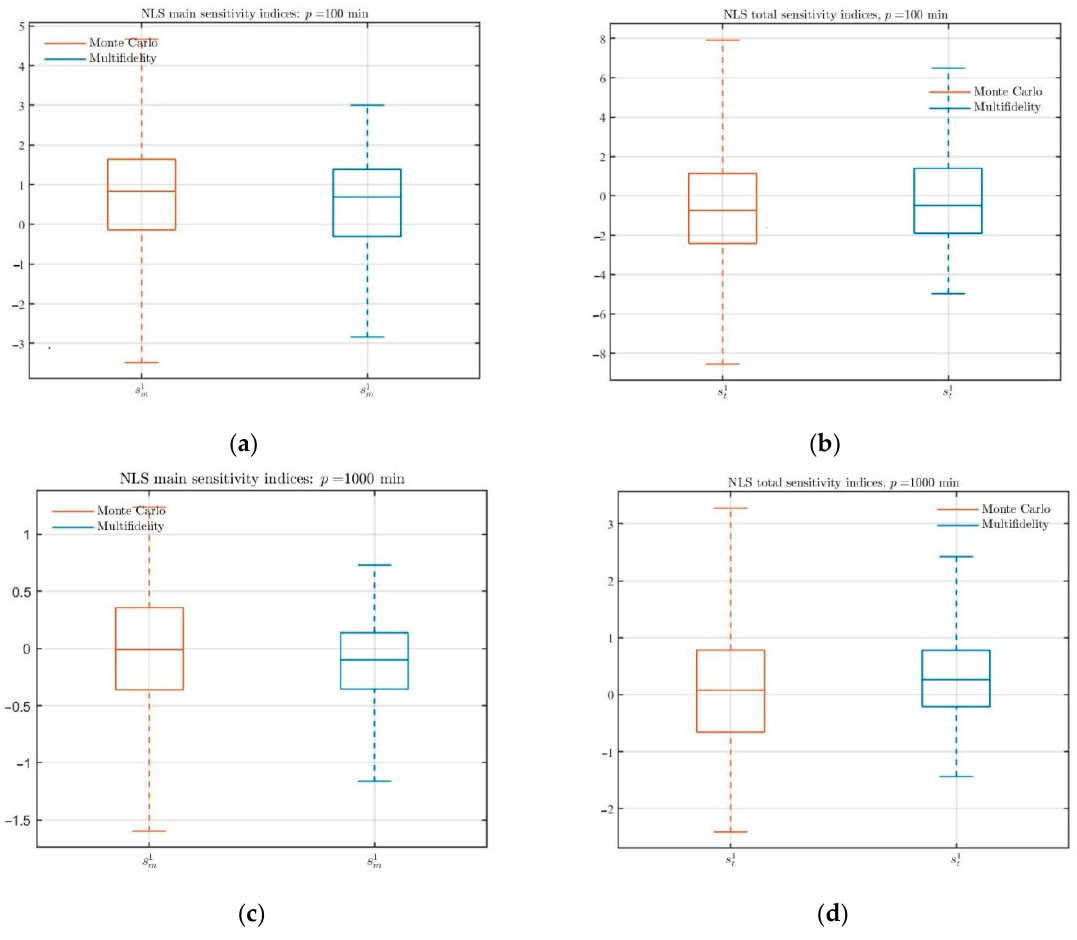
Figure 4. ( a , b ) Comparison of the MFMC and standard MC estimates of main or total effect sensi- tivities for the NLS Equation (18) with computational budgets = 100 p . ( c , d ) Comparison of the MFMC and standard MC estimates of main or total effect sensitivities for the NLS Equation (21) with computational budgets = 1000 p .